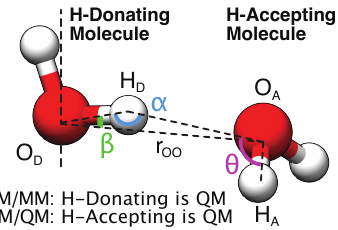
Figure 1. Illustration of the geometric quantities used in the water benchmarks. For the dimer tests and fits, we use the shorthand nomenclatures “QM / MM” and “MM / QM” to discern between the two possible subsystem configurations. Three angles provide insight into the hydrogen bonding network structure of liquid water, and are sampled in the molecular dynamics simulations: The donor angles α = ∠ ( O ) and β = ∠ ( H ) , and the acceptor angle θ = ∠ ( H ) . D ,H D ,O A D ,O D ,O A D ,O A ,H A